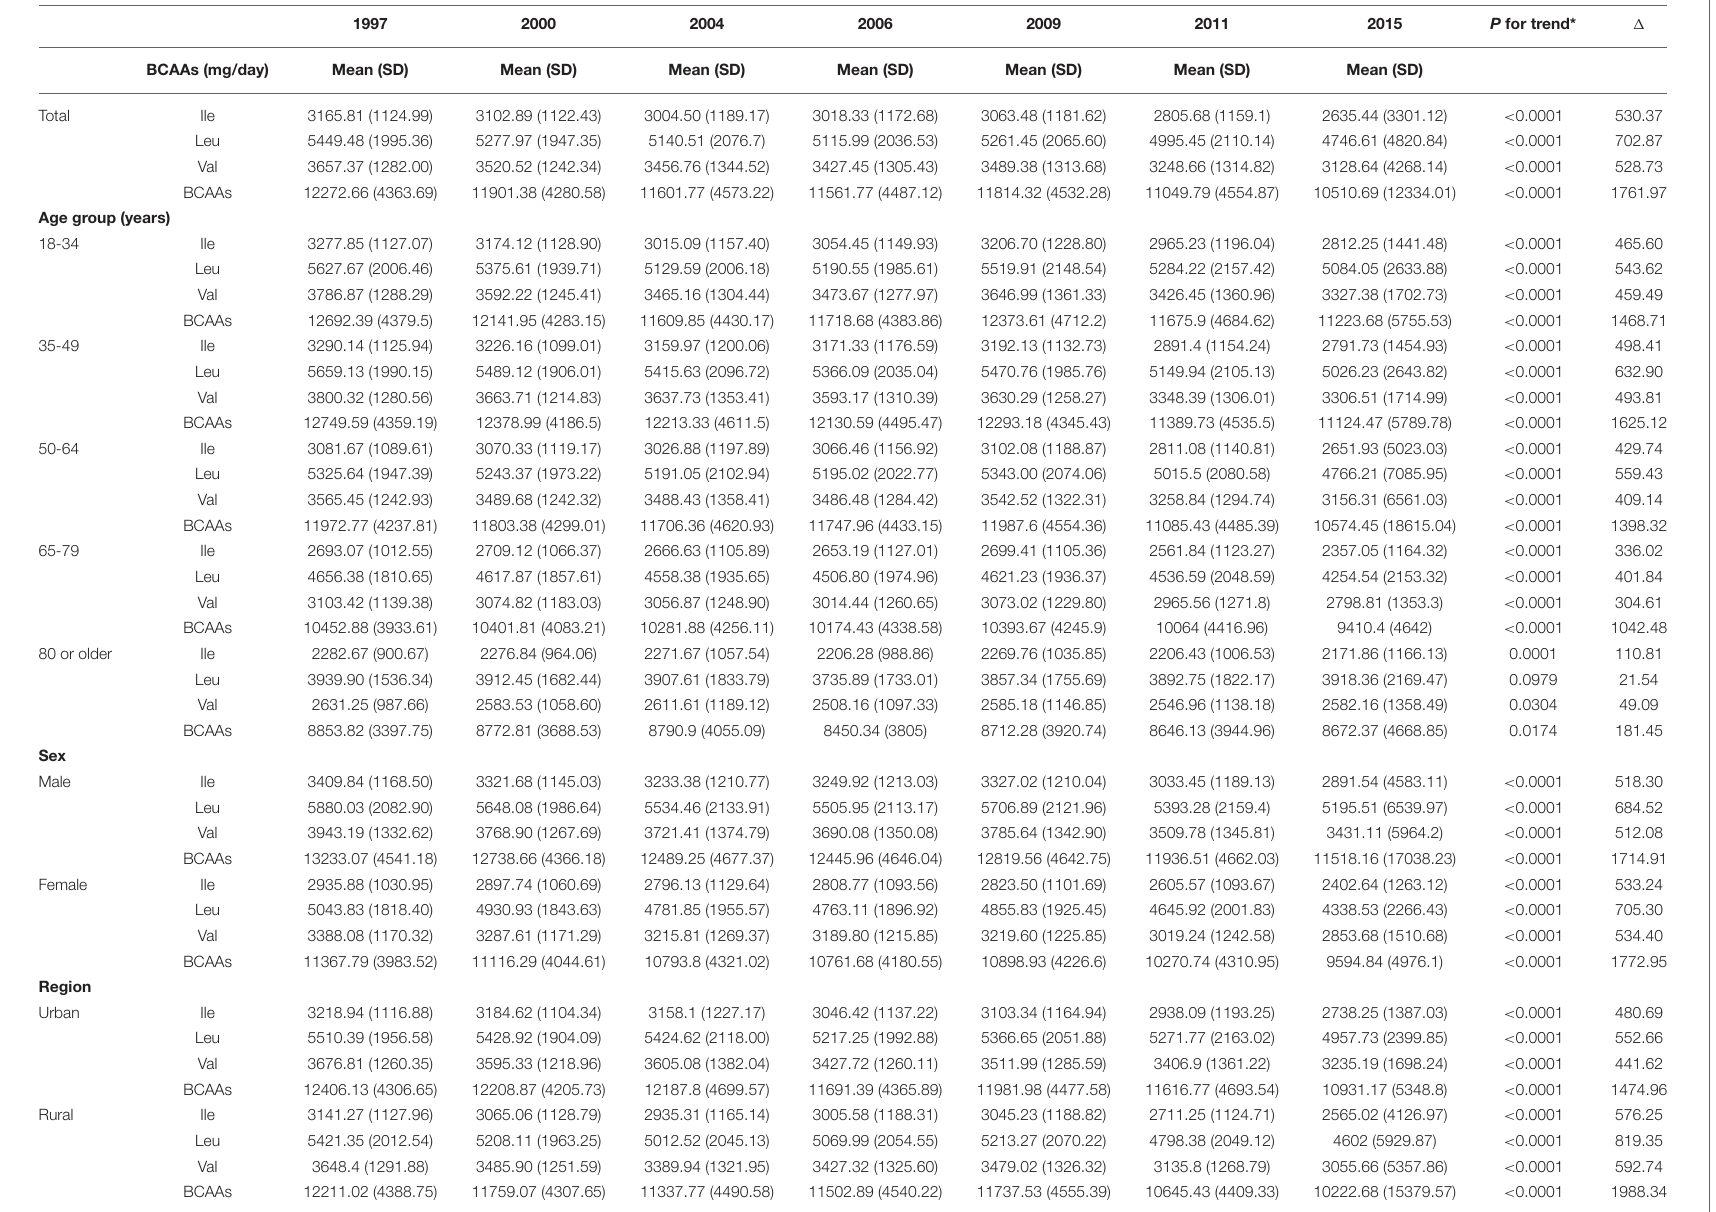
TABLE 2 | Trends in mean BCAAs intake among Chinese adults from